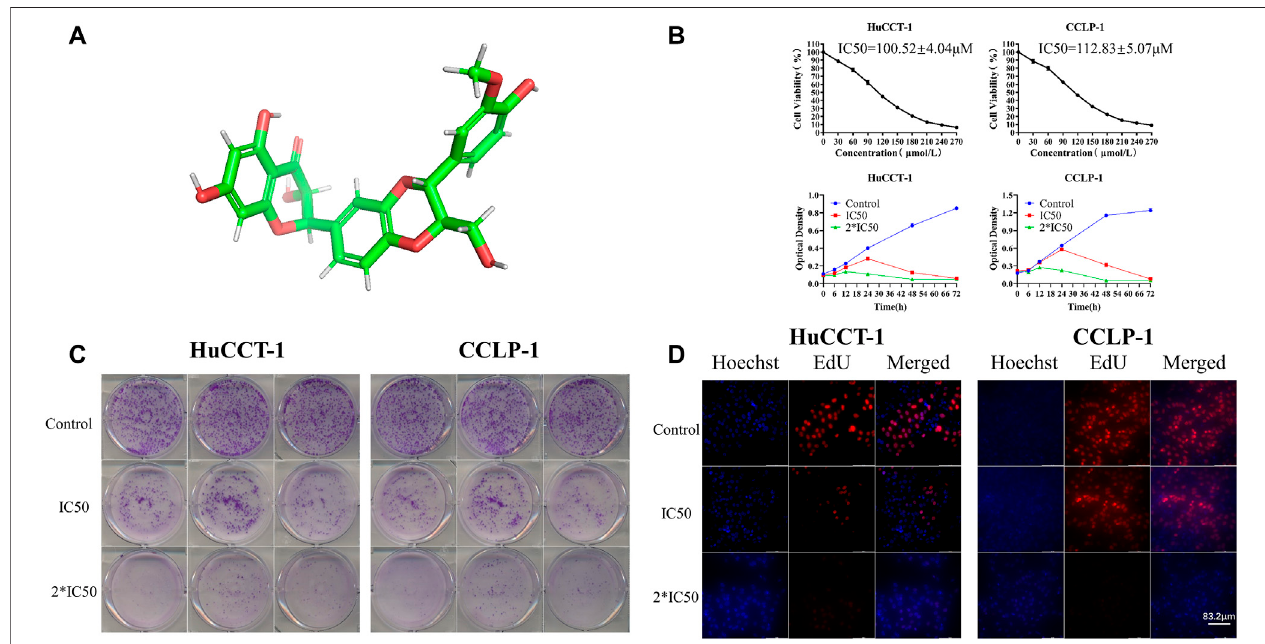
FIGURE 1 | Silibinin inhibits cell viability in cholangiocarcinomacells. (A) . Diagram of the three-dimensional structure of silibinin. (B) . Silibinin inhibited cell viability of HuCCT-1 and CCLP-1 cell lines in a concentration-dependent and time-dependent manner. Cells were treated with varying concentrations of silibinin for indicated time points (6, 12, 24, 48 and 72 h) and cell viability was examined by the CCK-8 assay. (C) . Colony formation assay results of HuCCT-1 and CCLP-1 cell lines treated with different concentrations of silibinin. (D) . EdU proliferation assay results of HuCCT-1 and CCLP-1 cell lines treated with different concentrations of